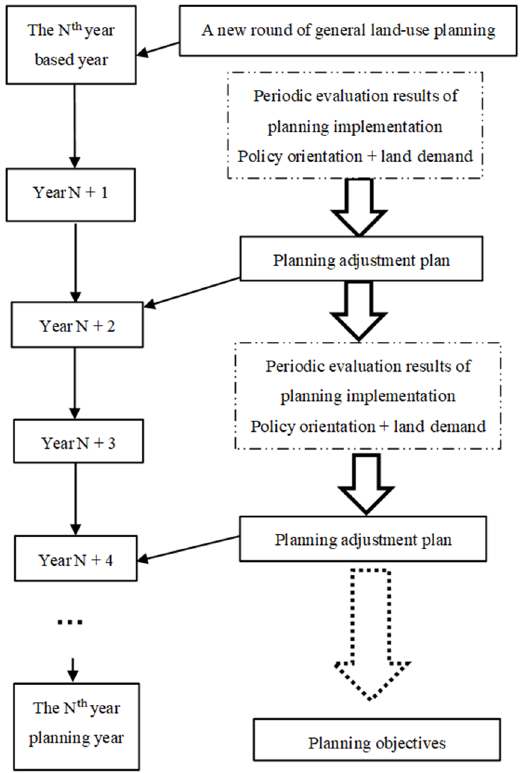
Figure 8. General plans for land-use periodic dynamic